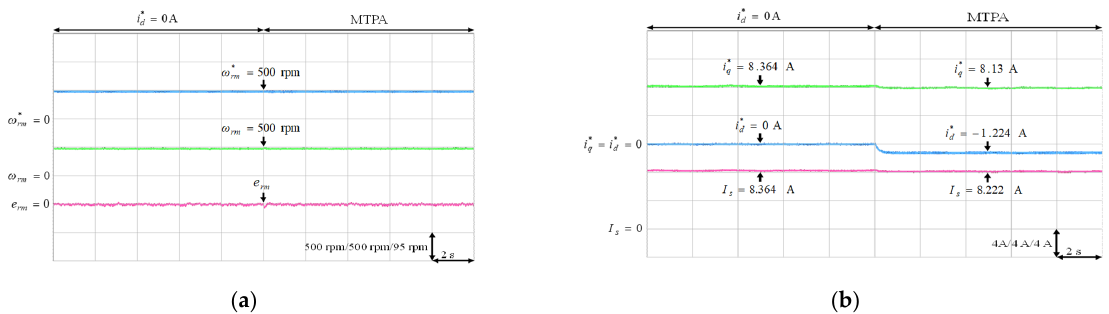
Figure 10. Training result of PPFNN-AMF.